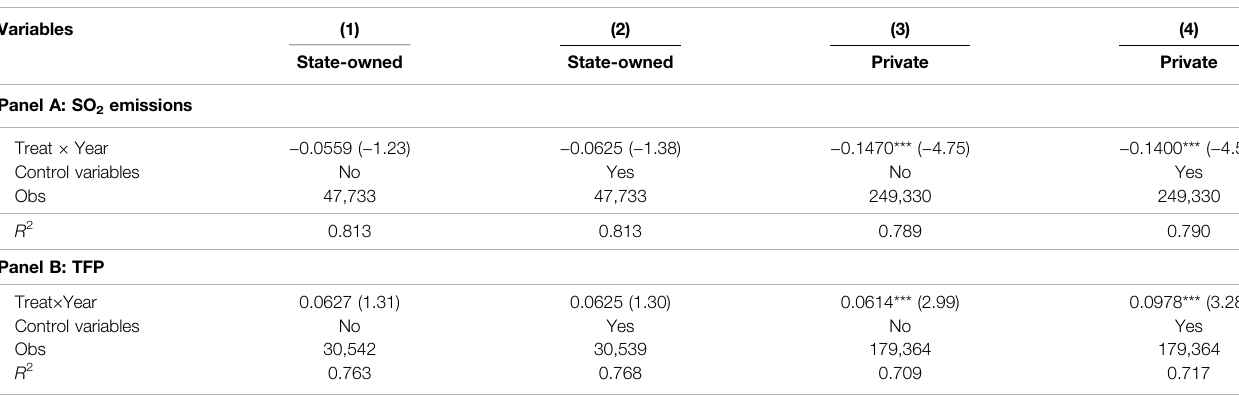
TABLE 10 | Heterogeneity regression results of property